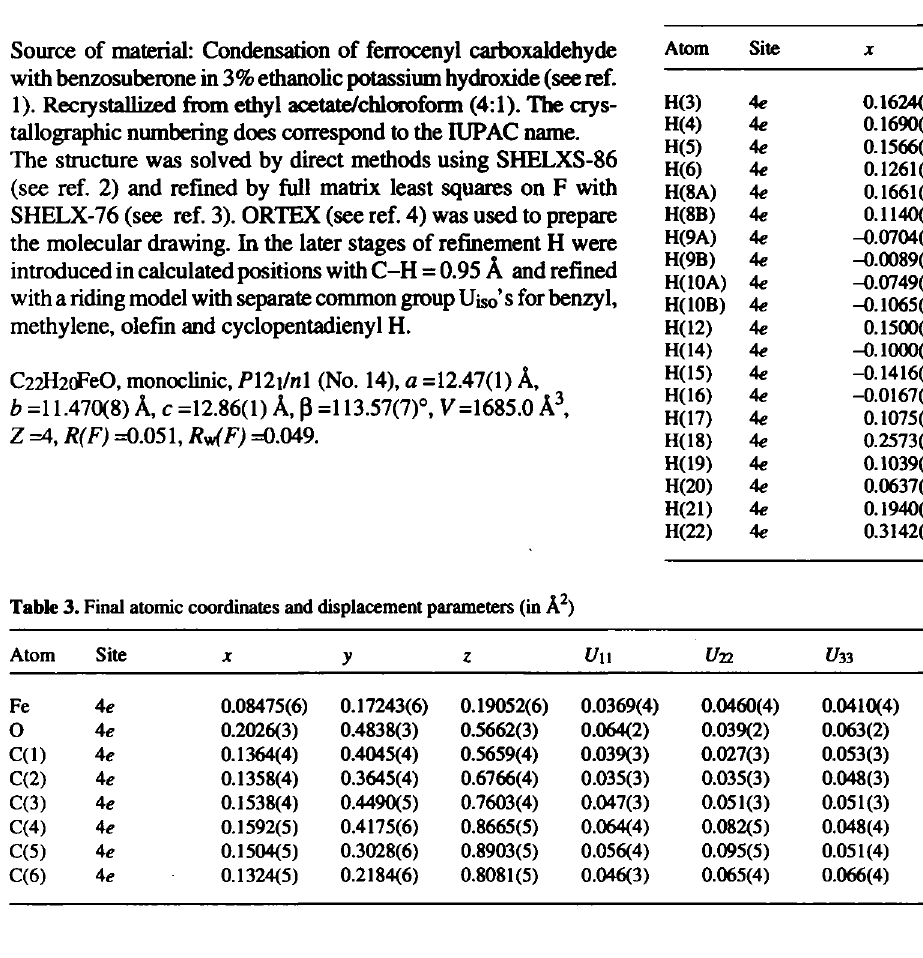
Table 2. Fmal atomic coordinates and displacement parameters (in